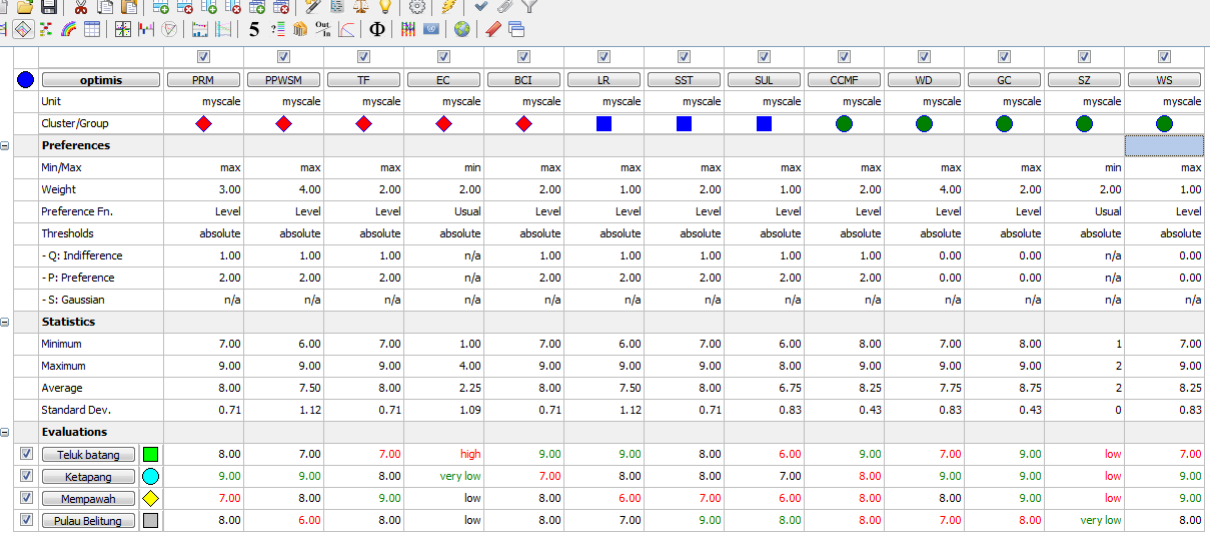
Figure 3. Red mud pilot plant site selection using visual PROMETHEE (VP) (see online version for colours).